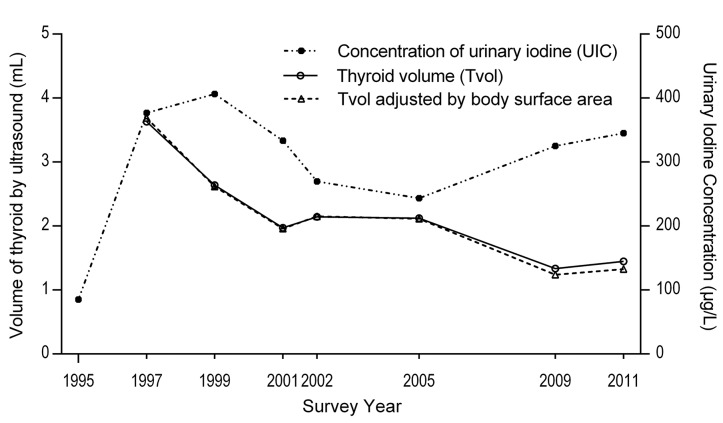
The geometric mean of thyroid volume (Tvol) and median urinary iodine concentration (right y-axis) in the surveys.Body surface area (BSA) was used to adjust Tvol and slightly affected the geometric mean of Tvol.